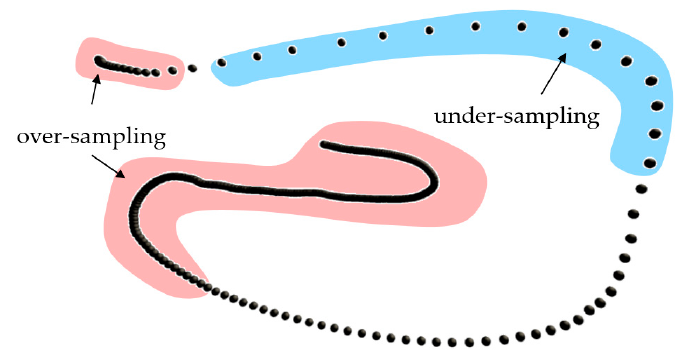
Figure 5. Diagram of over-sampling and under-sampling.